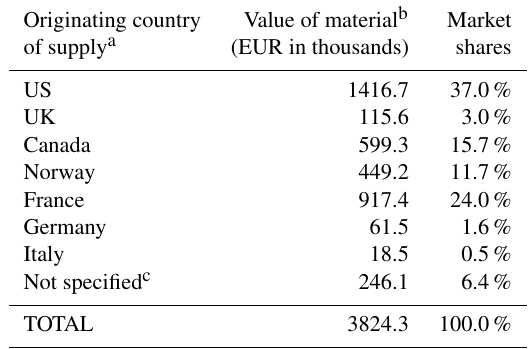
Table 3. Open-ocean equipment. INSU Brest